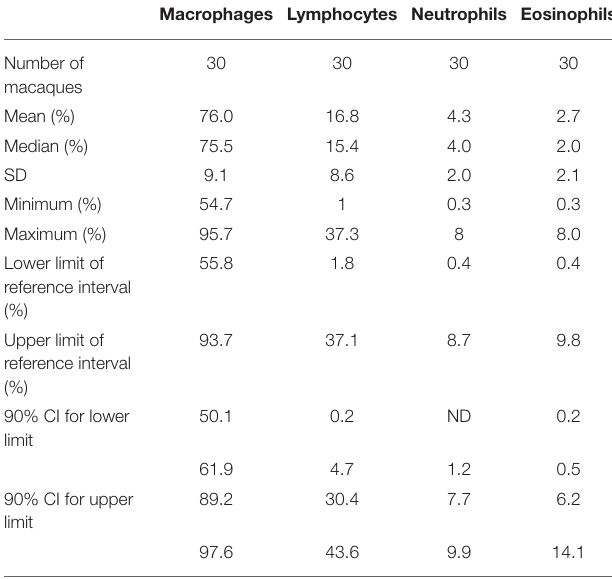
TABLE 1 | Descriptive statistics and reference intervals of differential cell counts in bronchoalveolar lavage (BAL) fluid in 3-years-old healthy macaques. Macrophages Lymphocytes Neutrophils